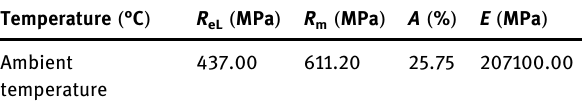
Table 2: Mechanical properties of P92 steel at ambient temperature Temperature ( °C )